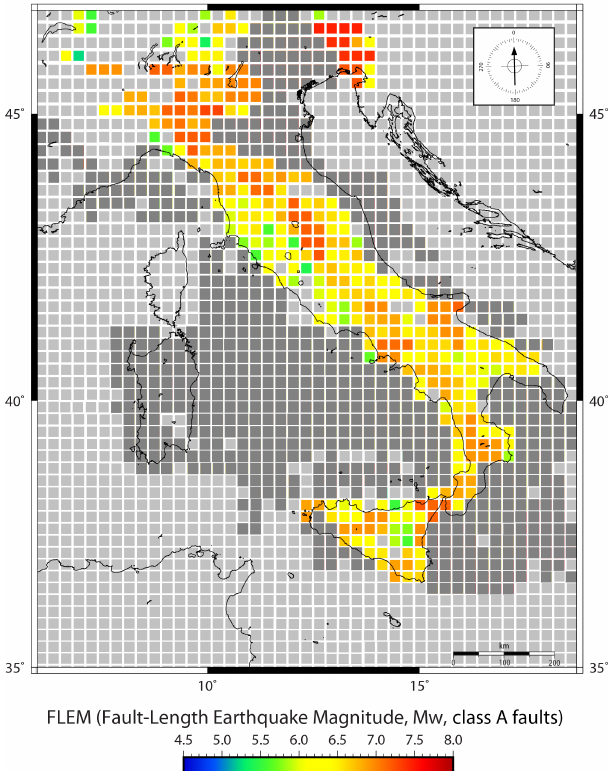
Figure 7. Map of the fault-length earthquake magnitude (FLEM) calculated, for each cell, from the length of class A faults. FLEM values are obtained using L10. Light grey is for cells with no data, whereas dark grey is for cells where the longest faults belong to the class B set. Note that these results should be considered more in a theoretical and methodological perspective for comparison with future similar studies rather than in an applicative perspective for the case of Italy. In particular, our assessed earthquake magnitudes for the Italian territory are here proposed for scientific reasons and not for their use for civil protection and prevention